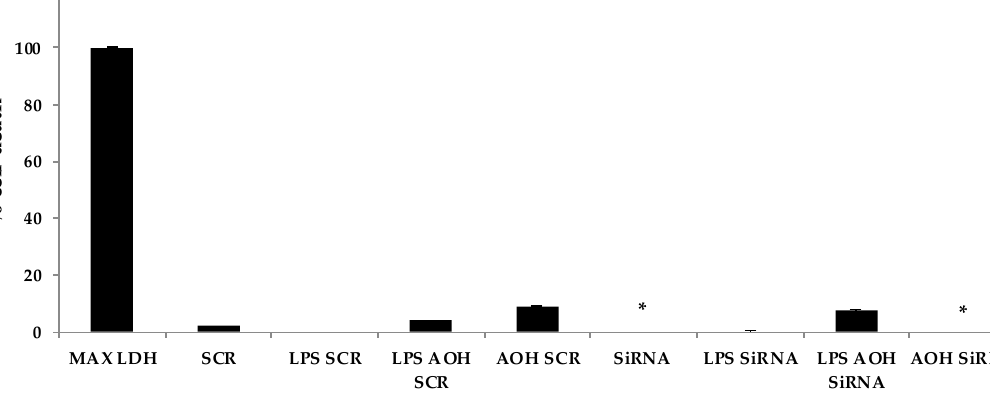
Figure 10. Alternariol (AOH) induced cell death is dependent upon the aryl hydrocarbon receptor (AhR). An LDH assay was performed on BEAS-2B cells with silenced AhR, 10 µ M AOH, and 10 µ g lipopolysaccharide (LPS). An * indicates p < 0.05 according to Student’s t -test when comparing AhR gene-specific (siRNA) treatments to their appropriate scrambled siRNA (SCR) controls.